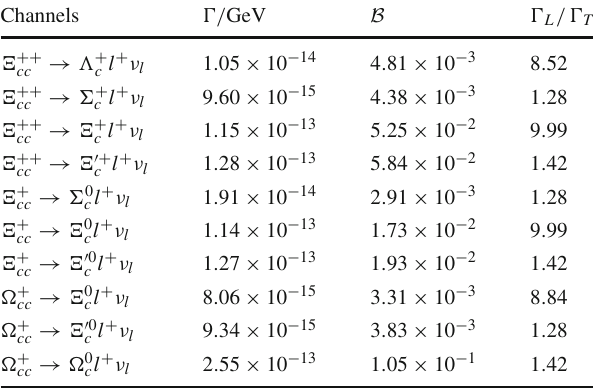
Table16 The cc sector:decaywidths,branching ratiosandthe (cid:14) L /(cid:14) T for semileptonic decays, with lepton mass neglected